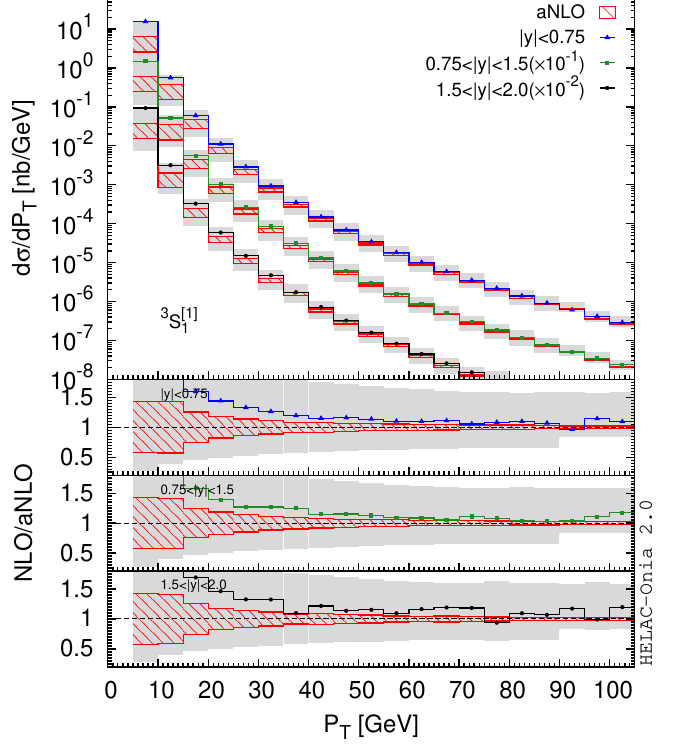
Figure 1 . Comparison of spin-summed differential cross sections for the Fock state 3 S [1] our aNLO calculations and the complete NLO calculations.